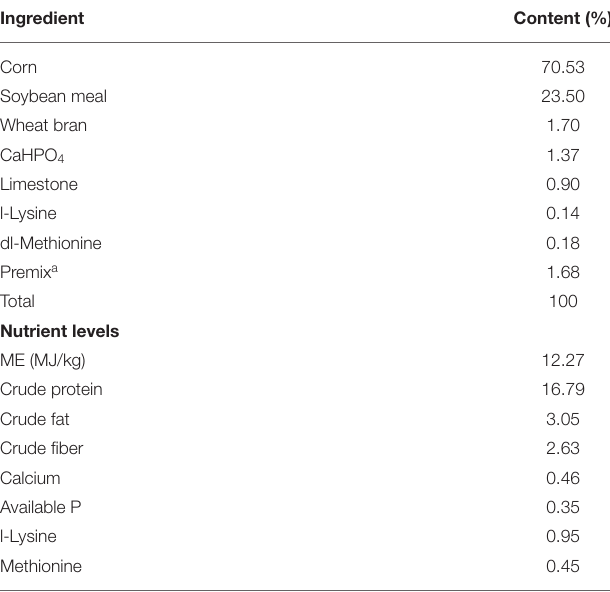
TABLE 1 | Composition and nutrition levels of the basal